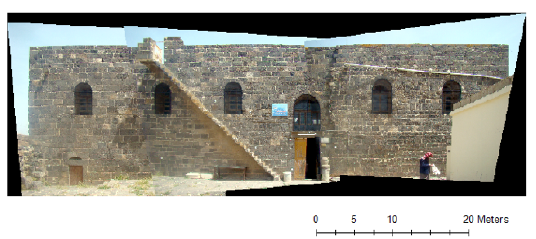
Figure 9. Photomosaic of Al Omari Mosque façade using GaiaOrtho free software